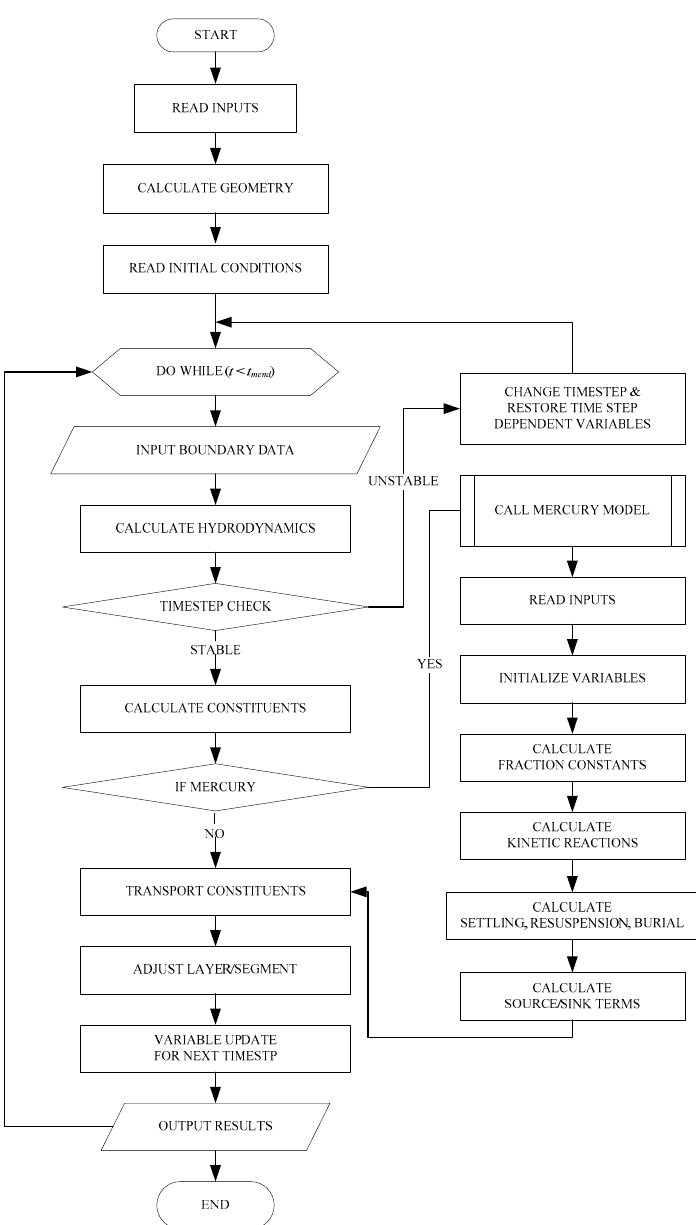
Figure 2. Flow chart of the W2 model solving the transport and mass balance of three Hg species.